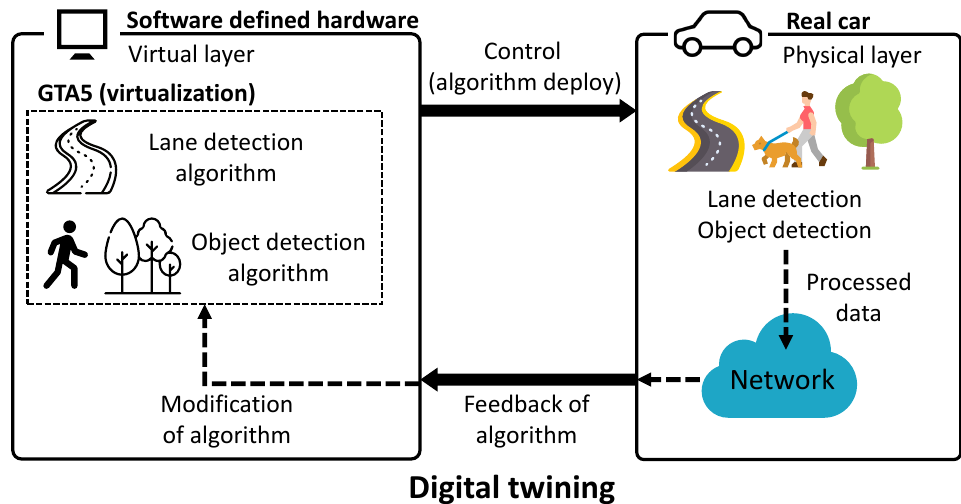
Figure 1. Summary of the structure of